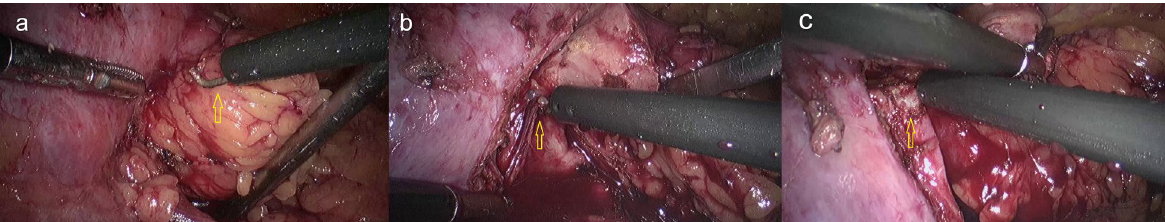
Fig. 4 a Electrosurgical suction irrigation device with L hook used for hot cut (marked with yellow arrow). b Progression of tumor resection by electrosurgical suction irrigation device (marked with yellow arrow). c Segmental arterial injury during tumor resection (marked with yellow arrow) (not identifiable at that stage and was identified during retrospective analysis of the recorded video)